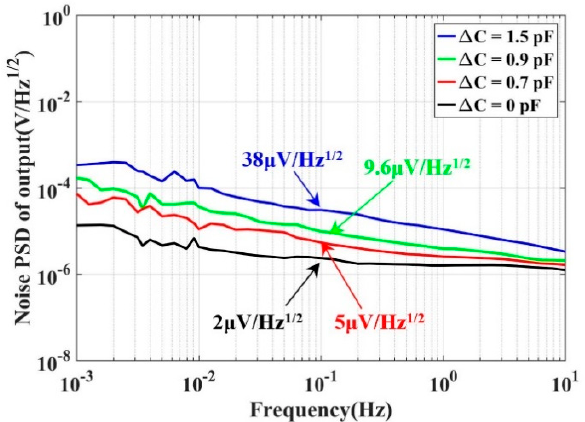
Figure 5. The output noise of the capacitive transducer with different Δ C values. This indicates that a larger differential capacitance Δ C results in a worse output noise.